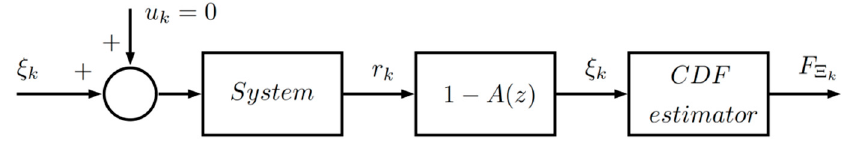
Figure 3. Estimation process of the error distribution function (cid:1832) (cid:2950)